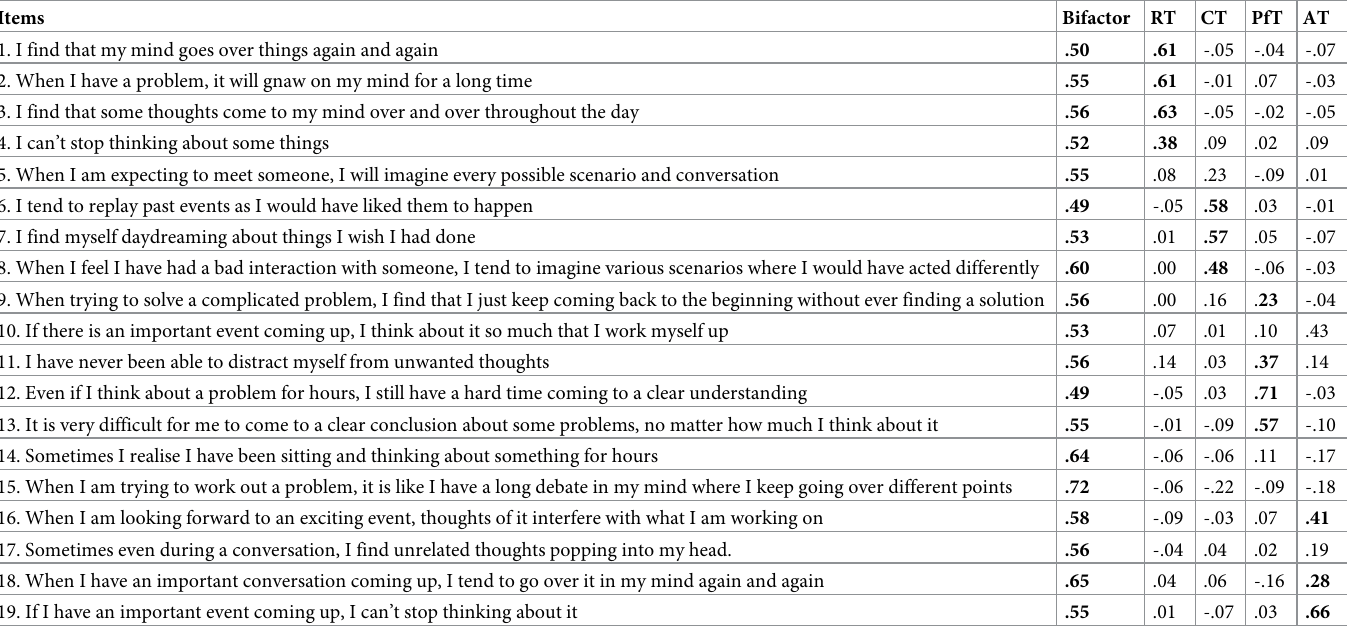
Table 2 shows the fit indices for each model. Model 1 did not fit the data, while both Model 2 and Model 3 indicated unsatisfactory fit. The only acceptable model was Model 4, implying that the variance was best explained by a bifactor ESEM structure, where 14 out of 19 items loaded on the subfactors besides the general factor. Standardized factor loadings of Model 4 are presented in Table 3. Internal consistency of the best fitting model (bifactor ESEM). The Cronbach α s of the total score of the RTSQ and its subscales demonstrated good internal consistency, in line with previous findings [24,27]. In order to eliminate the errors in the estimation of internal consis- tency, the omega total and omega hierarchical coefficients were calculated (for details see Table 4). Given that the omega total of the RTSQ was .939 and the omega hierarchical coefficient for the whole scale was .851 we could assume that only 15% of the total score variance was Table 3. Standardized factor loadings of the bifactor ESEM of the